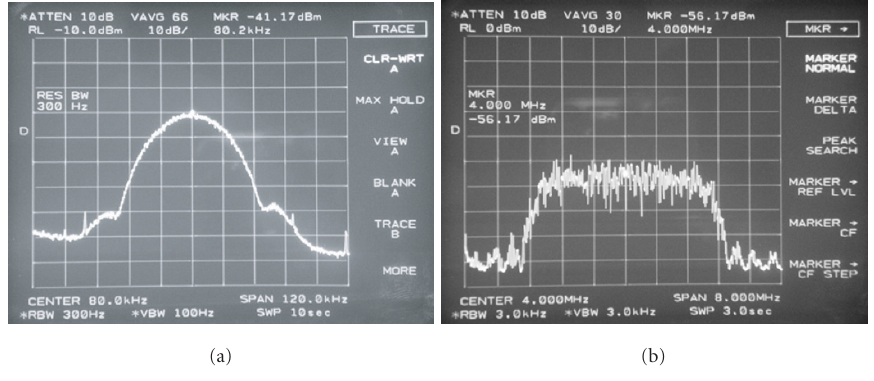
Figure 10: GMSK transceiver.